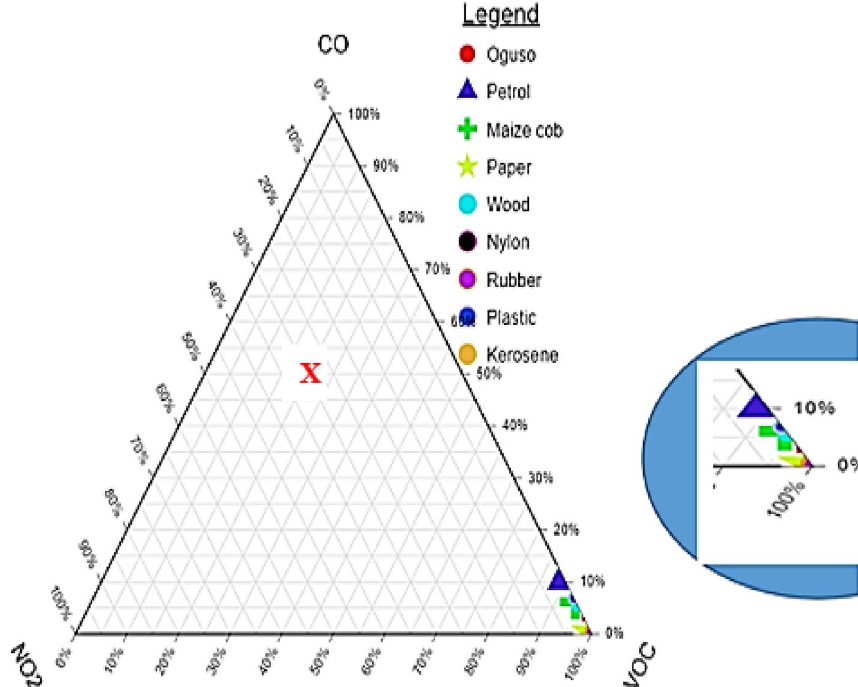
Figure 5. Ternary plot of combustion indices (enlarged section at the right); CO (%), NO 2 (%) and VOC (%).